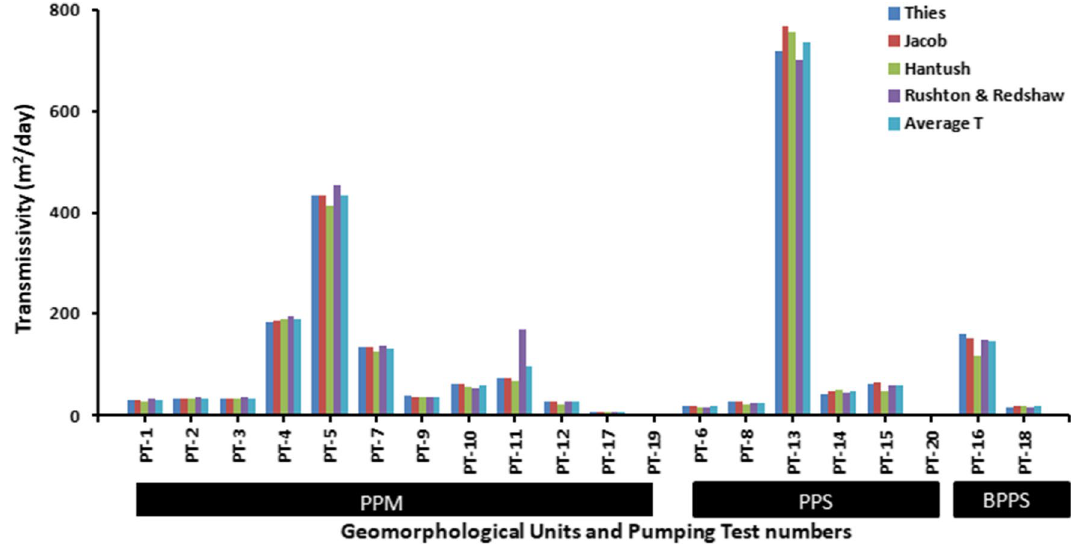
Fig. 10 Variation of transmissivity (m 2 /day) values in pediplain with moderate weathering (PPM), pediplain with shallow weathering (PSS) and buried pediplain with shallow weathering (BPPS) geomorphologic